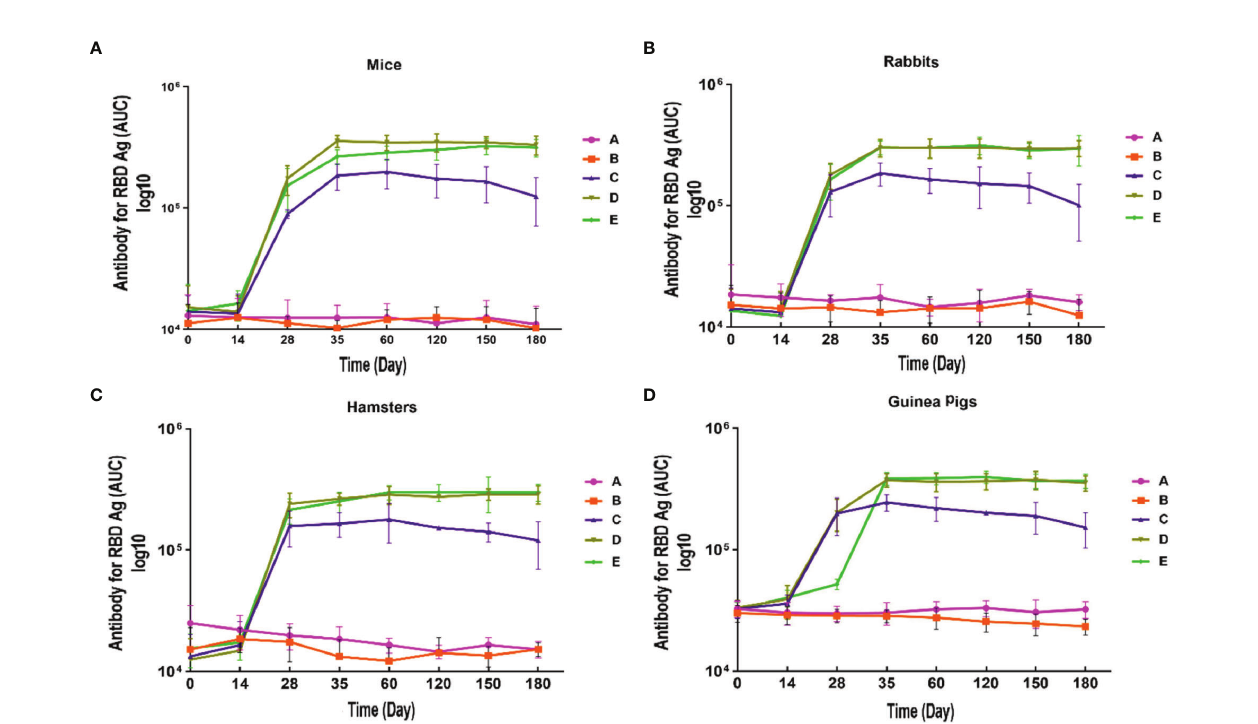
FIGURE 3 | Anti-SARS-CoV-2 immunoglobulin-G (IgG) antibody titers against RBD antigen in different animal models immunized with candidate vaccine. (A) Anti- SARS-CoV-2 immunoglobulin-G (IgG) antibody titers against RBD for 180 days from the day it is received candidate vaccine in mice. (B) Anti-SARS-CoV-2 immunoglobulin-G (IgG) antibody titers against RBD for 180 days from the day it is received candidate vaccine in rabbit. (C) Anti-SARS-CoV-2 immunoglobulin-G (IgG) antibody titers against RBD for 180 days from the day it is received candidate vaccine in hamster. (D) Anti-SARS-CoV-2 immunoglobulin-G (IgG) antibody titers against RBD for 180 days from the day it is received candidate vaccine in guinea pig. Data are presented as mean ± SD. The levels of statistical signi fi cance for differences between test groups were determined using one-way ANOVA followed by Tukey ’ s post hoc test. Statistical comparison was done by comparing the vaccinated group with the placebo group as a control. A signi fi cant increase of IgG against the RBD was observed one week after the second dose of the candidate vaccine (day 28) in all animal groups receiving the candidate vaccine and remained signi fi cantly higher until day 180 in compared with the groups receiving placebo and adjuvant (P<0.001). Placebo (adjutant of RAS-01) (group A), phosphate buffered saline (PBS, group B), low dose candidate vaccine (group C), medium dose candidate vaccine (group D), and high dose candidate vaccine (group